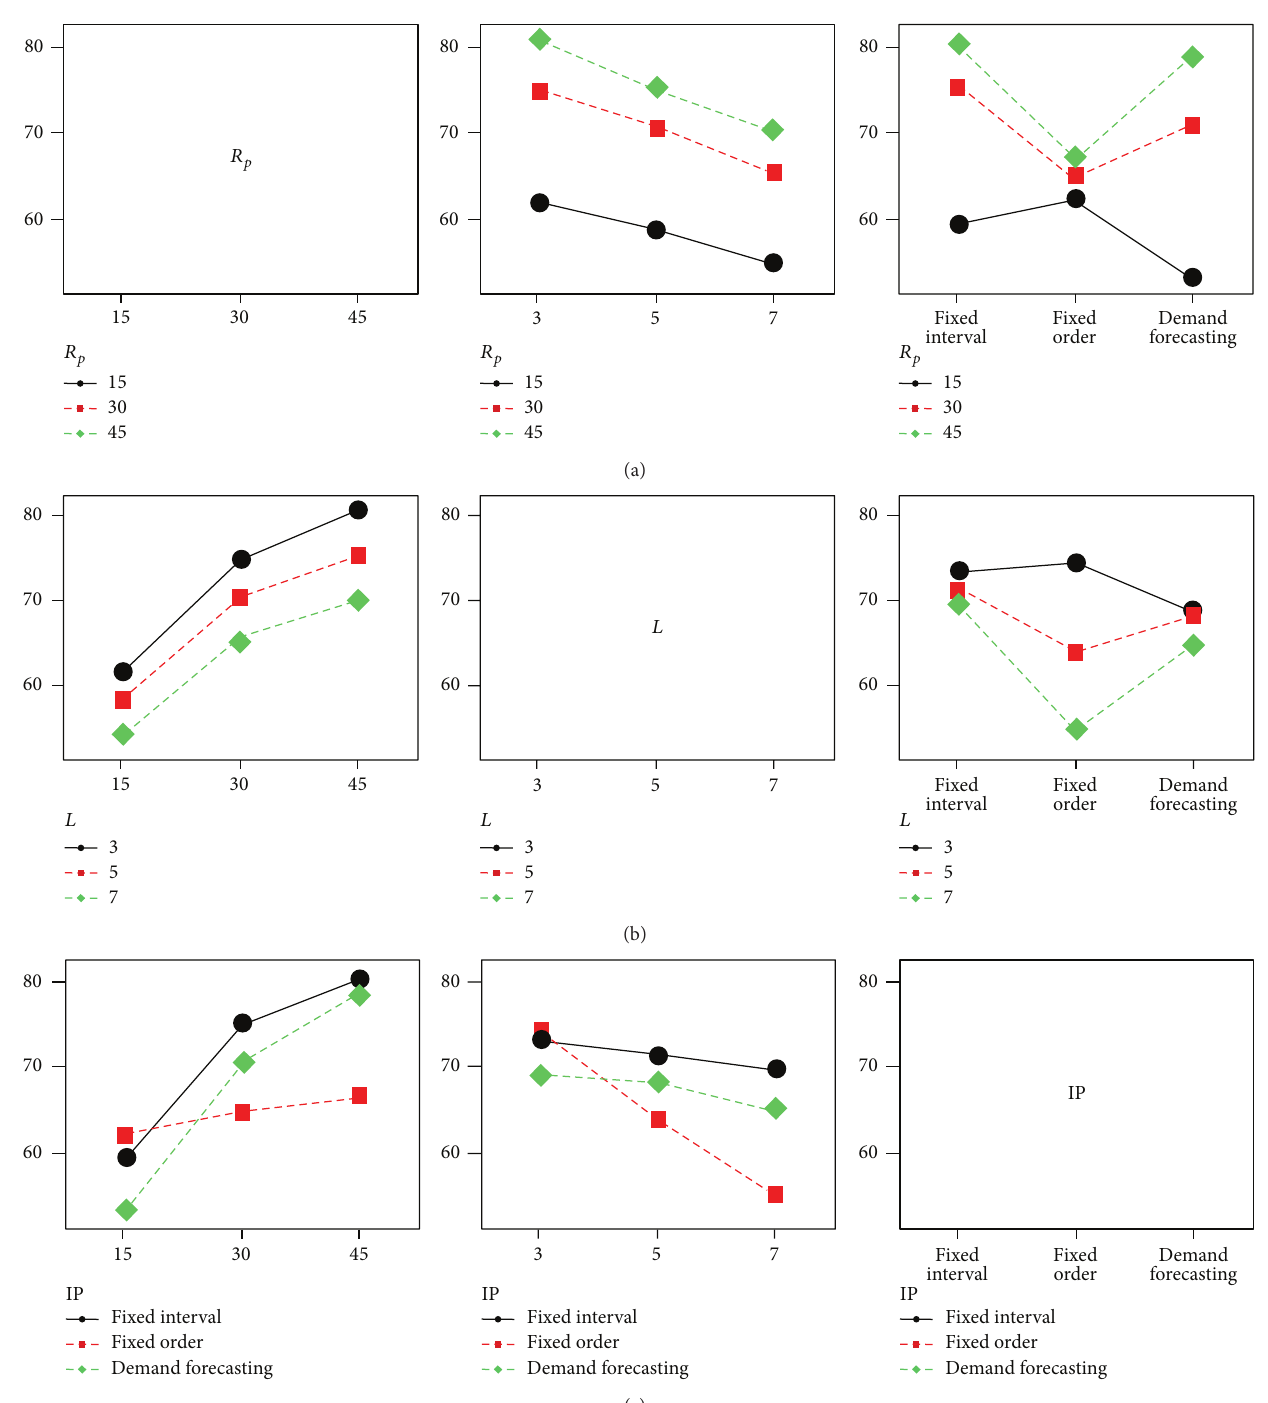
Figure 6: Interaction plot for product 𝐶 : service level